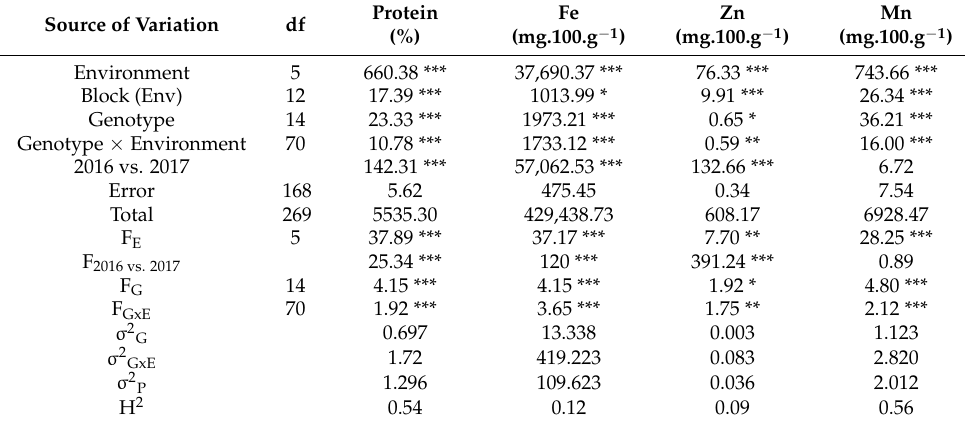
Table 4. Mean squares, degrees of freedom (df), and F values produced in the analysis of variance as well as estimates of variance for Genotype (G), Genotype by Environment interaction (GxE), and phenotype (P) and broad sense heritability (H 2 ) for protein content, and concentrations of Fe (iron), Zn (zinc), and Mn